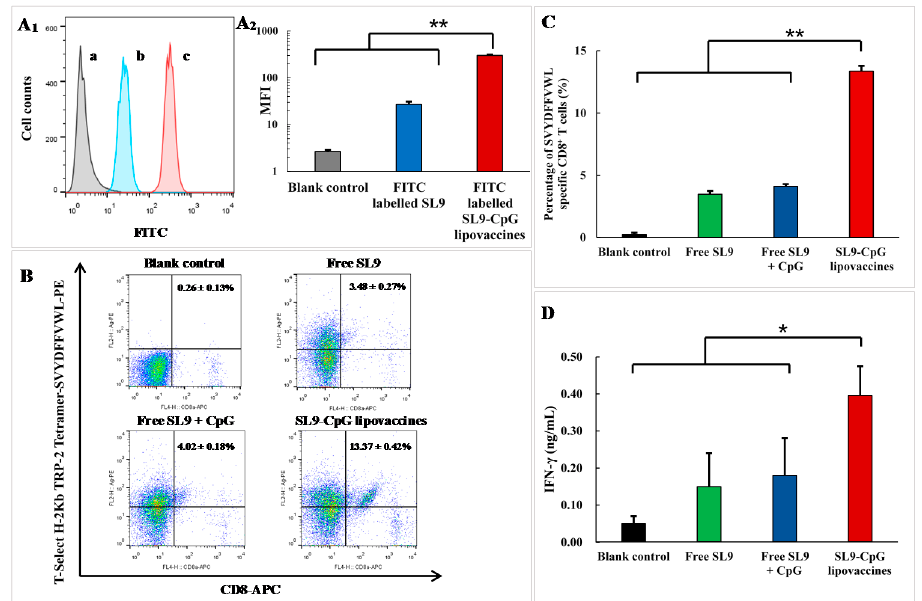
Figure 3. Cellular uptake and immune response in melanoma-bearing mice. Flow cytometry histogram ( A1 ) and statistical results ( A2 ) of cellular uptake by inguinal lymph node cells: a, blank control; b, fluorescein isothiocyanate (FITC)-labeled SL9 (5 µ g / mL SL9-FITC); c, FITC-labeled SL9-CpG lipovaccines (5 µ g / mL SL9-FITC, 30 µ g / mL CpG). Data are presented as mean ± standard deviation ( n = 3). ** p < 0.01. Scatter diagrams ( B ) and statistical results ( C ) of SVYDFFVWL-specific CD8 + T cells activated by SL9-CpG lipovaccines (5 µ g / mL SL9, 30 µ g / mL CpG) or controls. Data are presented as mean ± standard deviation ( n = 3). ** p < 0.01. IFN- γ expression levels in peripheral blood by ELISA after immunization with SL9-CpG lipovaccines (5 µ g / mL SL9, 30 µ g / mL CpG) or controls ( D ). Data are presented as mean ± standard deviation ( n = 3). * p <